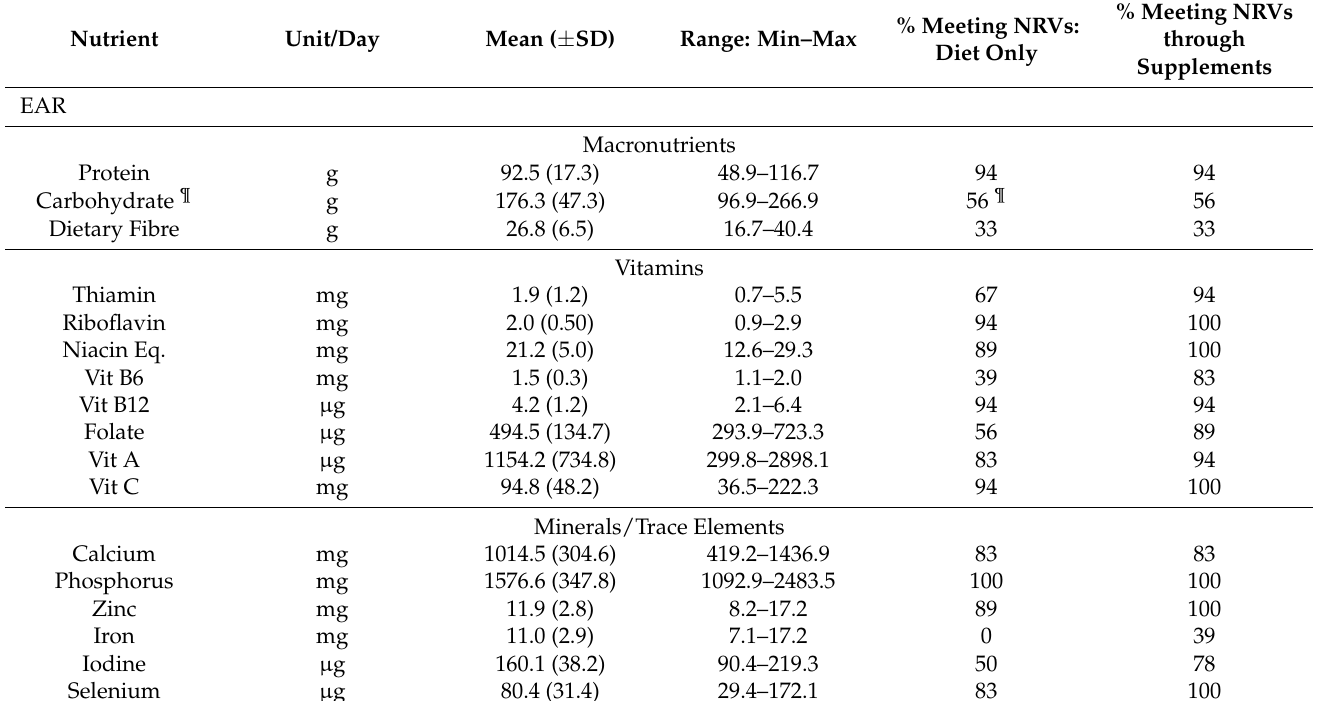
Table 1. Mean ( ± SD) and Range of Nutrient Intake of Women in the present study and Percentage of Appropriate Nutrient Reference values Met Based on Pregnant Women Aged 19–50